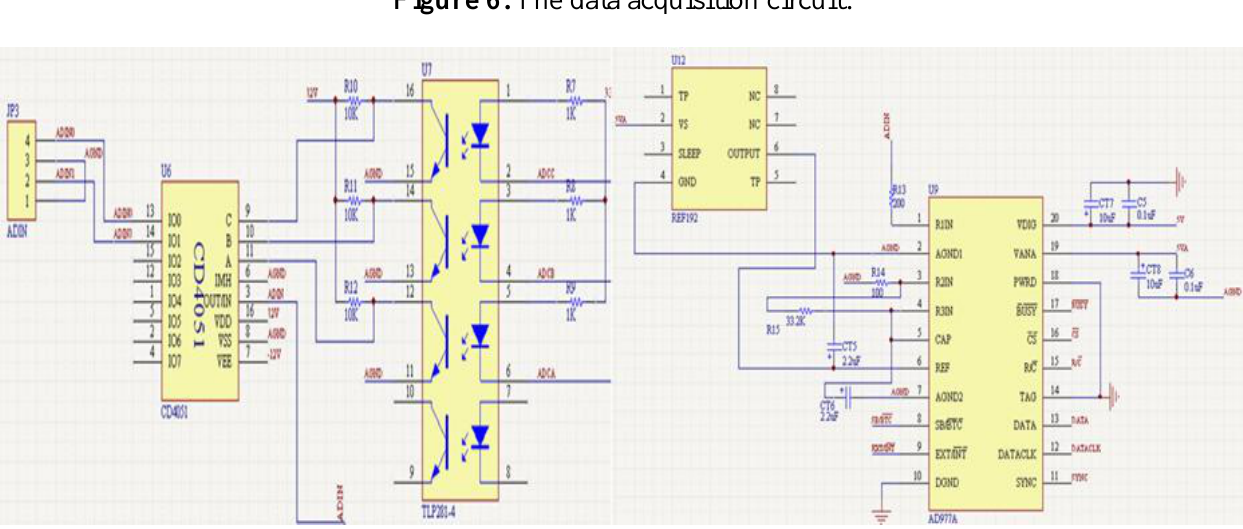
Figure 6. The data acquisition